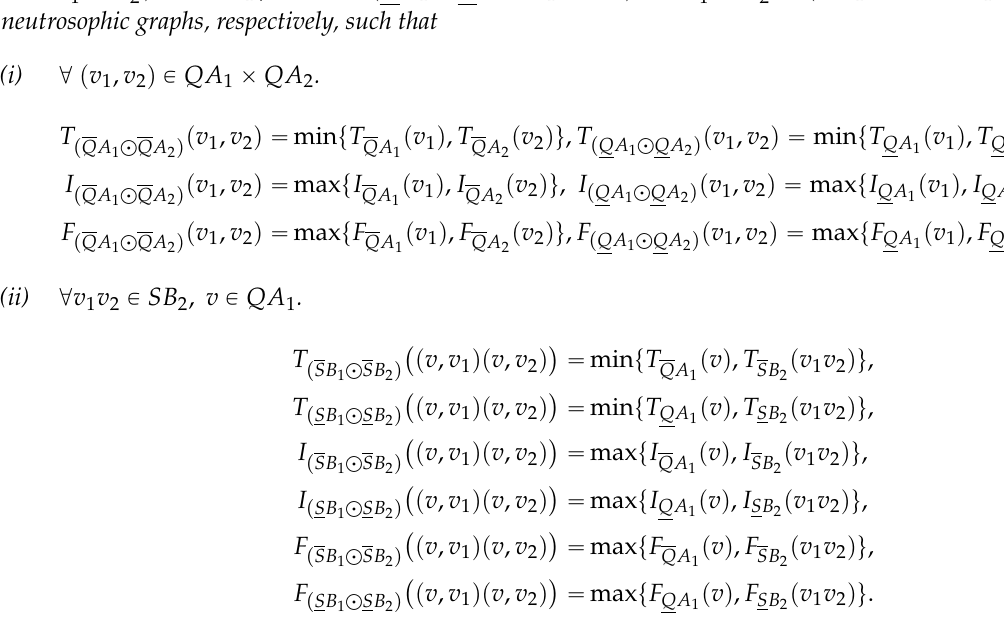
G 2 = ( G G 2 ) G 2 , G 1 1 ⊕ ⊕ ⊕ G 2 = ( G G 2 ) Figure 8. Neutrosophic soft rough graph G 1 ‘ G 2 “ p G 1 ‘ G 2 , G 1 ‘ G 2 G 2 , G 1 1 ⊕ ⊕ ⊕